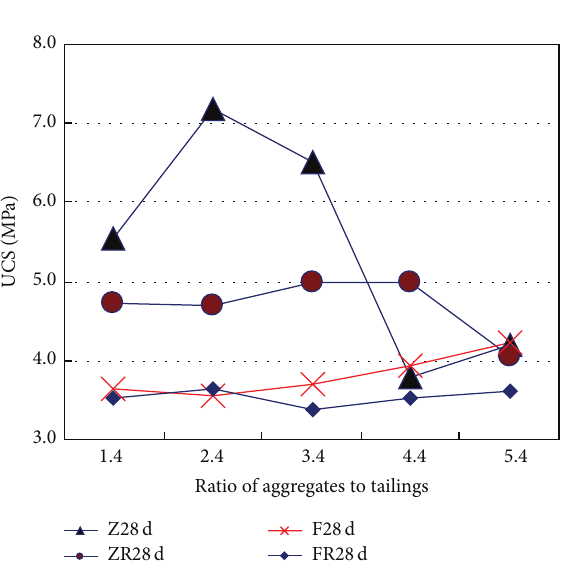
Figure 3: 28-day backfill UCS using 19% cement replacement.